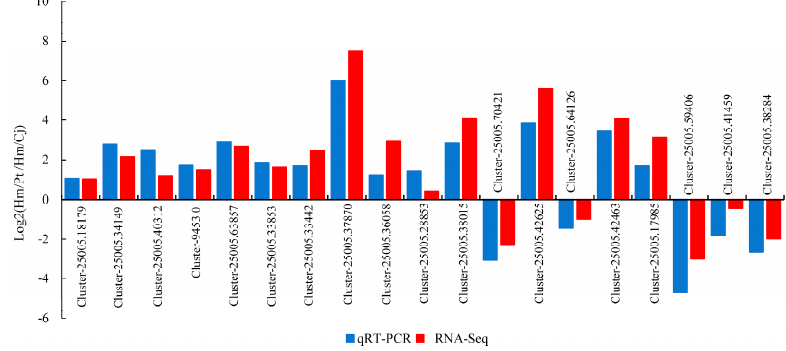
Figure 4. Expression pattern of 19 selected genes obtained by RNA-seq and real-time quantitative PCR (qRT-PCR) methods.